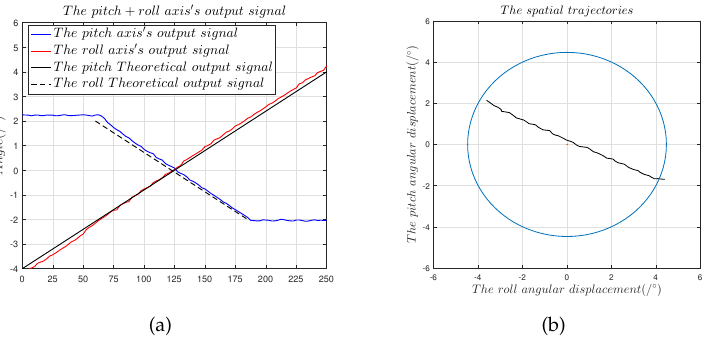
Figure 20. Dual-axis measurement experiments in the 150° direction: ( a ) solution results of the angular displacement signals α 1 and α 2 ; ( b ) 150° displacement trajectories fitted by α 1 and α 2